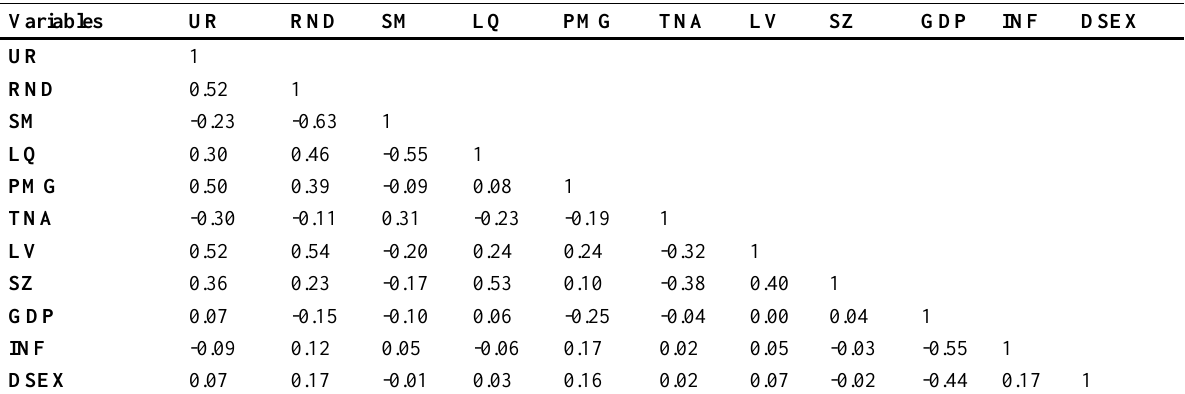
Table-11: Correlation